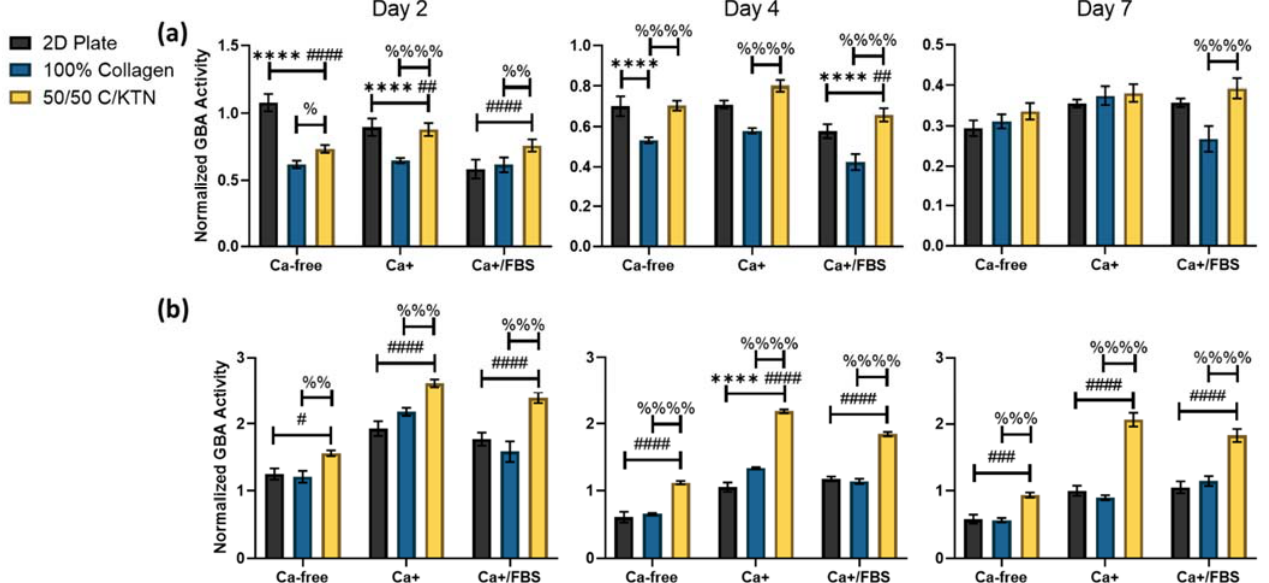
Figure 2. GBA activity of immortalized and primary keratinocytes influenced by KTN and media supplements. GBA activity was normalized to cell viability. Immortalized cells showed significant increase in GBA activity when KTN was added to the hydrogel, but no increase when calcium and FBS was added to the media ( a ). NHEKs showed significant increase in GBA activity when KTN was added to the hydrogel, with increases also observed with addition of calcium and FBS ( b ). GBA activity is displayed as weighted average ± SD. Two-way ANOVA was performed with n = 4 for 3 separate experiments. The different symbols (*, #, %) correspond to the comparisons and the number of symbols correspond to the p-value for each comparison: * = p < 0.05, ** = p < 0.01, *** = p < 0.001, **** = p < 0.0001 and * = 2D plate vs. 100% collagen, # = 2D plate vs. 50/50 C/KTN, % = 100% collagen vs. 50/50 C/KTN. Table 2. Comparison of GBA activity between different media within each sample group. GBA activity was normalized to cell viability. For most samples, especially for primary NHEKs, addition of calcium increased the GBA activity; addition of FBS also further increased the GBA activity. Two-way ANOVA was performed with n = 4 with 3 separate experiments. * = p < 0.05, ** = p <